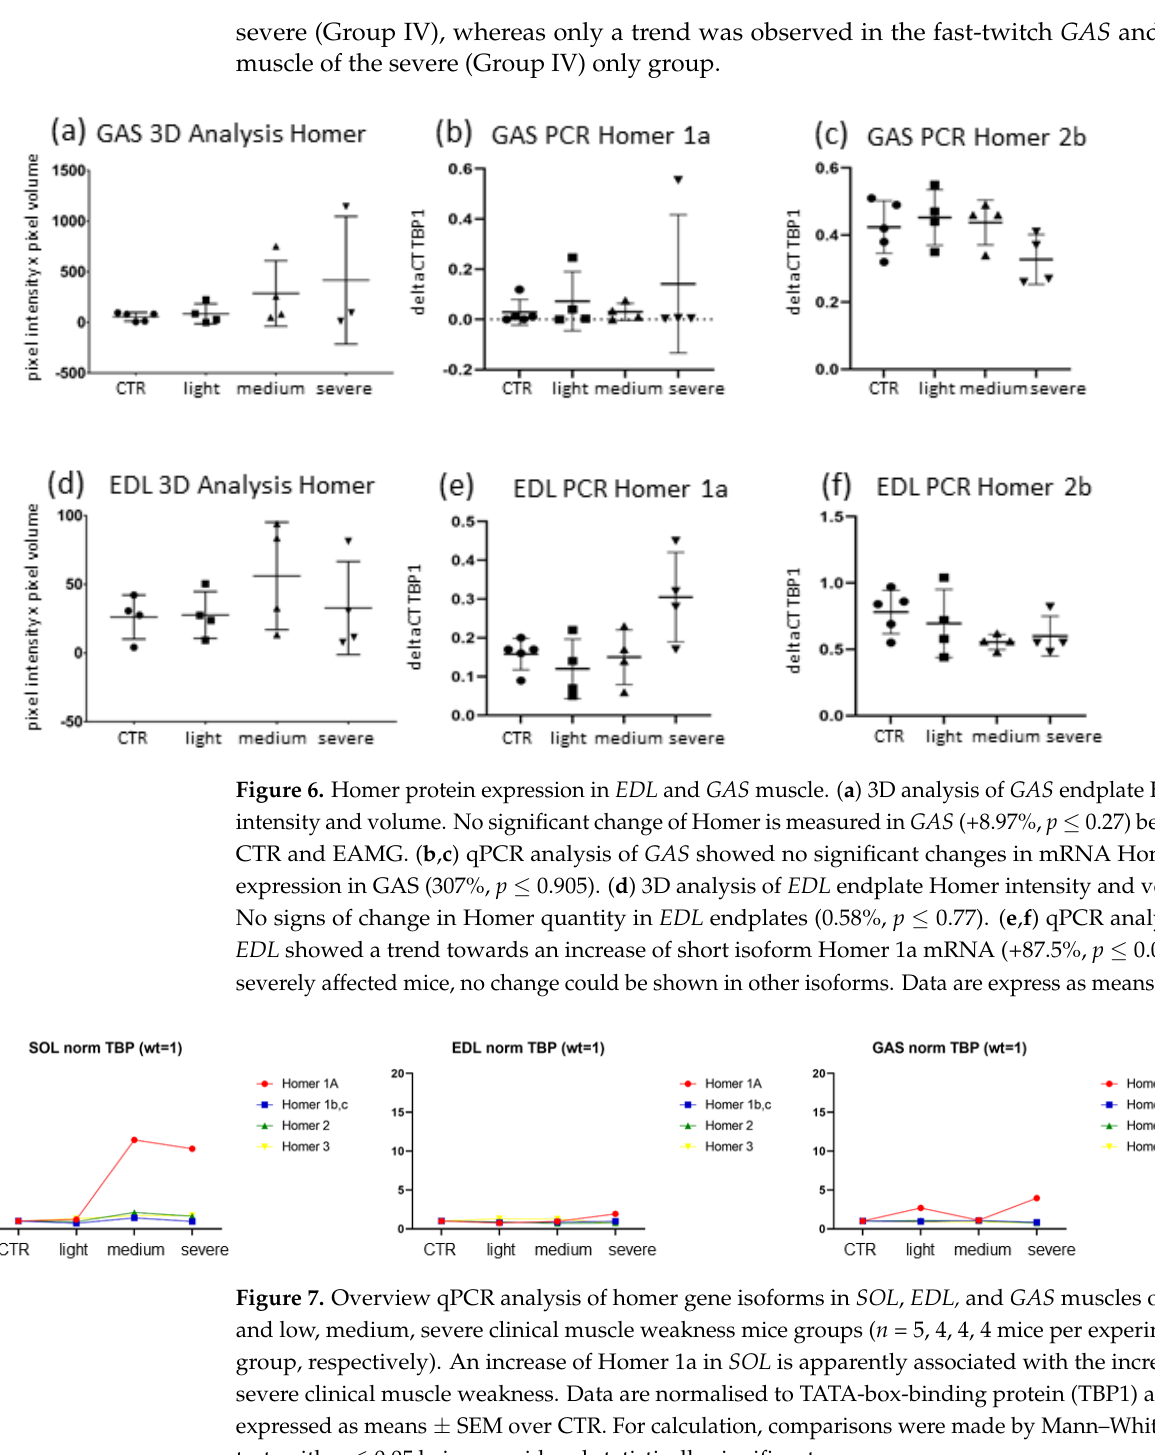
Figure 7. Overview qPCR analysis of homer gene isoforms in SOL , EDL, and GAS muscles of CTR and low, medium, severe clinical muscle weakness mice groups ( n = 5, 4, 4, 4 mice per experimental group, respectively). An increase of Homer 1a in SOL is apparently associated with the increase of severe clinical muscle weakness. Data are normalised to TATA-box-binding protein (TBP1) and are expressed as means ± SEM over CTR. For calculation, comparisons were made by Mann – Whitney- U test, with p ≤ 0.05 being considered statistically significant.